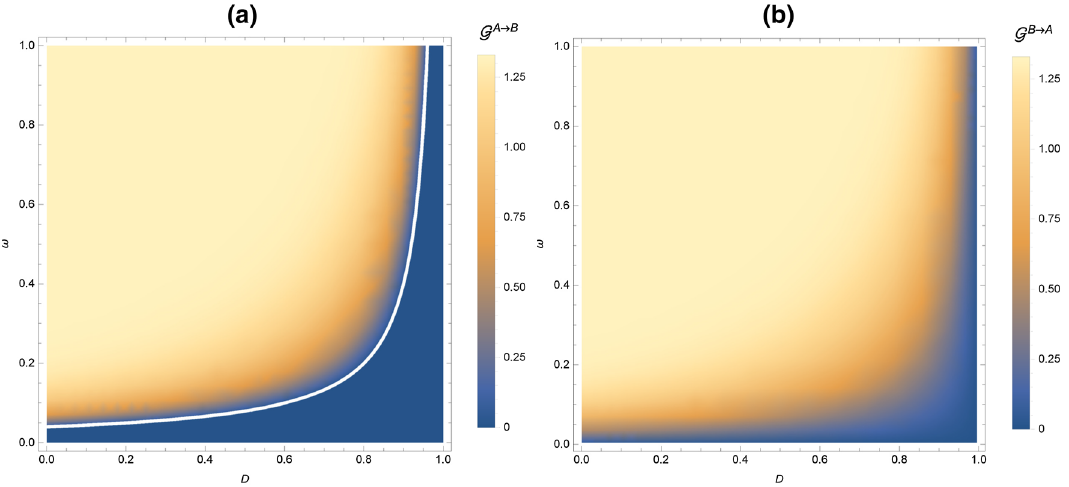
Fig. 1 The Gaussian quantum steerability G A → B (left) and G B → A (right) are functions of the dilaton parameter D of the GHS dilaton black hole and the frequency ω of the field. The initial squeezing parameter and mass parameter are fixed as s = 1 and M = 1